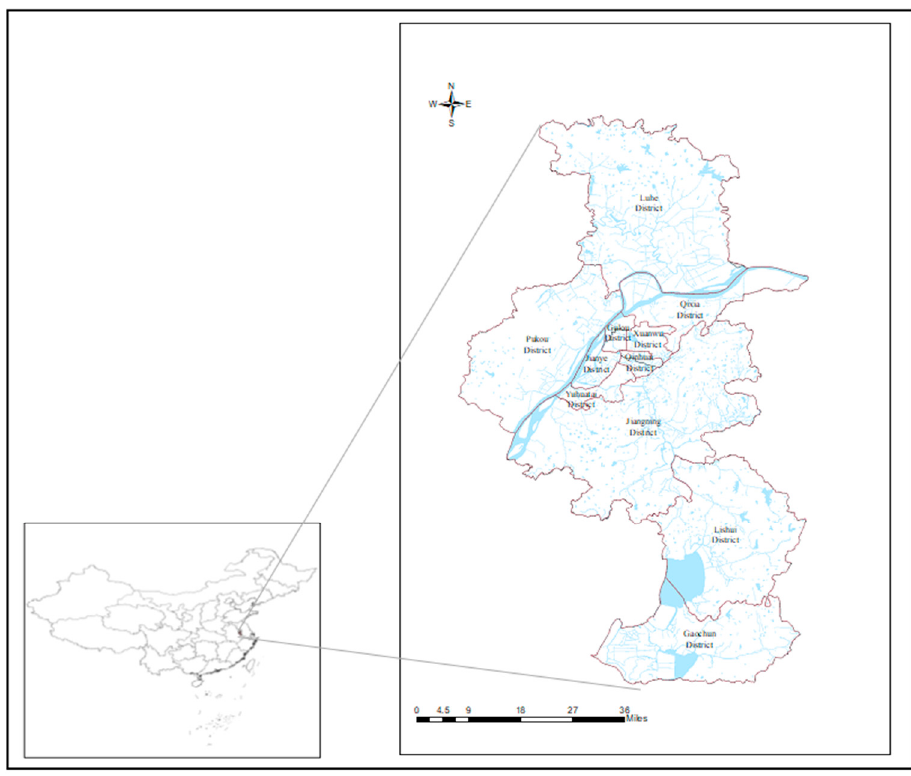
Figure 1. The location of 11 districts in Nanjing, China.